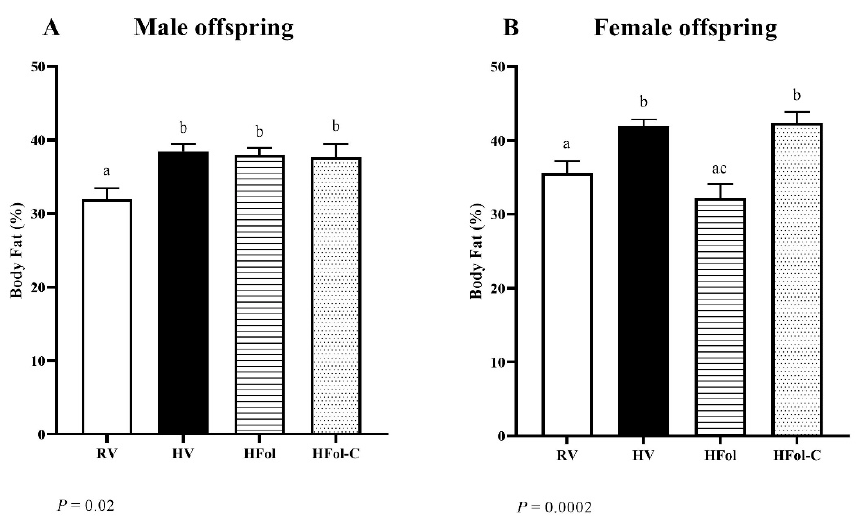
Figure 6. Body fat percentage, in percent, calculated as percent fat mass adjusted by total mass, in ( A ) male and ( B ) female offspring at 12 weeks post-weaning. Diet abbreviations: RV, recommended vitamin; HV, high multivitamin; HFol, high folic acid with recommended choline; HFol-C, high folic acid without choline. Superscripts indicate p ≤ 0.05 by one-way ANOVA followed by the Tukey–Kramer post hoc test, n = 10–12/group. Values are mean ± SEM.